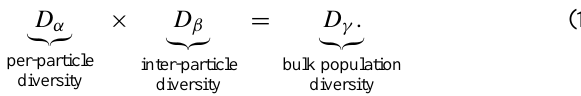
Fig. 4: Generalized per-particle diversity q D i of order q for varying q , shown for three different particles (inset square plots). Left: a particle with equal amounts of two species. Center: a particle with two species in unequal amounts. Right: a particle with three species in unequal amounts. The order q controls the importance of species with small mass fraction. When q = 0 all species are taken to be equally present, irrespective of mass fraction, so 0 D i is simply the number of species present in the particle. When q = 1 the generalized diversity is equal to the regular diversity defined from the Shannon entropy in Section 2. When q = 2 the gen- eralized diversity 2 D i is the inverse of the Simpson index A  i = ( p a ) 2 for particle i (Simpson, 1949), often used i a =1  i (Peet, 1974; in the form of the Gini-Simpson index 1  P Jost, 2006).